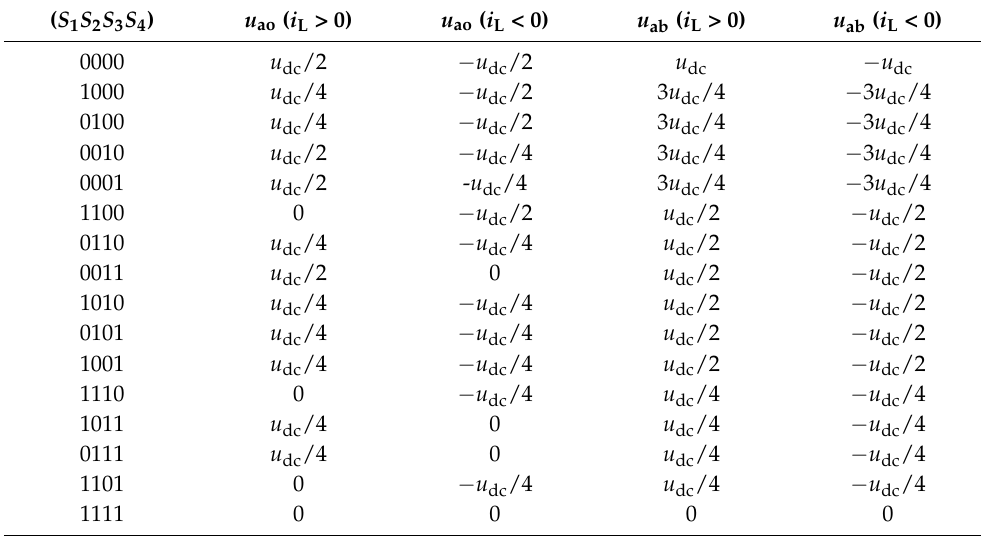
Table 1. The relationship between output level and switching states.